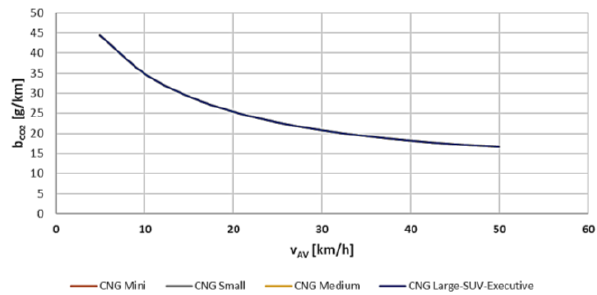
Fig. 4. CO 2 emission from LPG PCs for Euro standards depending on average speed